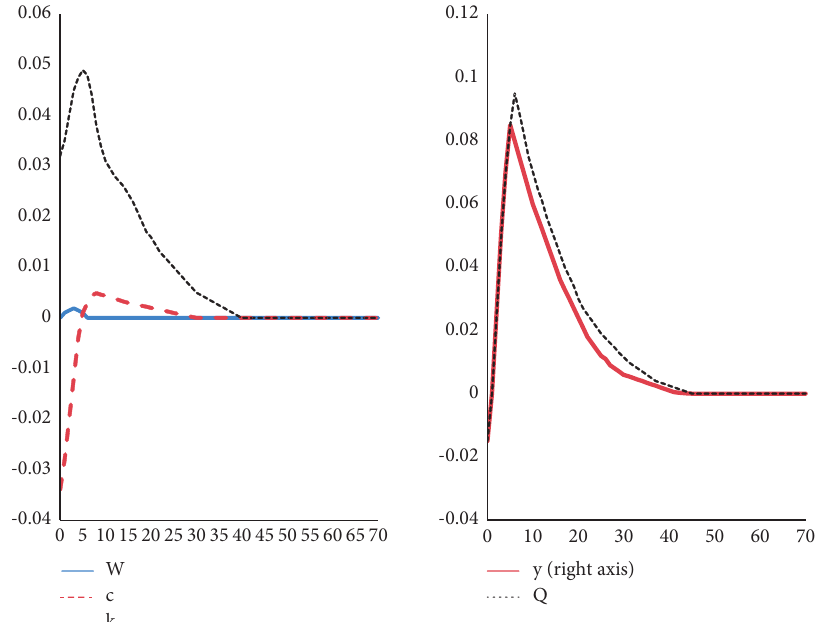
Figure 5: Response diagram of some endogenous variables under the impact of ship environmental preference.